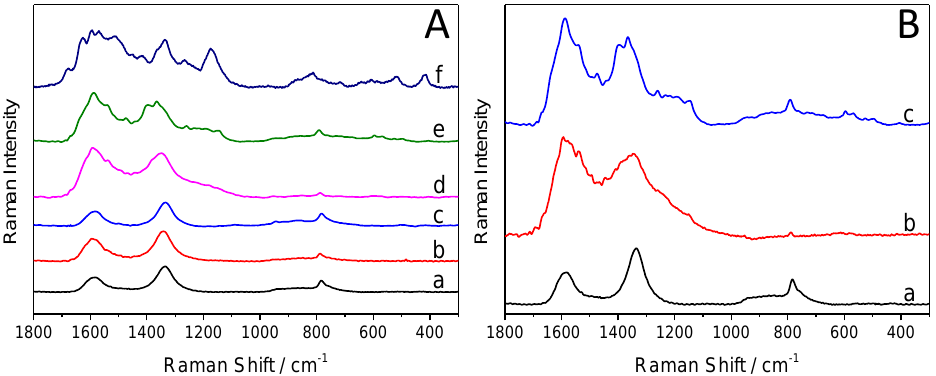
Figure 4. ( A ) Raman spectra of the pure silicon carbide (SiC) and PANI, and the SiC/PANI nanocomposites (with the UV component filtered below 300 nm): ( a ) SiC, ( b ) SiC/PANI, 5 min of illumination, ( c ) SiC/PANI, 10 min of illumination, ( d ) SiC/PANI, 30 min of illumination, ( e ) SiC/PANI, 60 min of illumination, ( f ) PANI; ( B ) Raman spectra of the synthesized nanocomposite samples: ( a ) SiC, ( b ) SiC/PANI 60 min of illumination, UV-illuminated, ( c ) SiC/PANI 60 min of illumination, UV-filtered. Table 1. Characteristic Raman bands of PANI. The bands appearing on the spectra of the SiC/PANI nanocomposites are marked with grey.